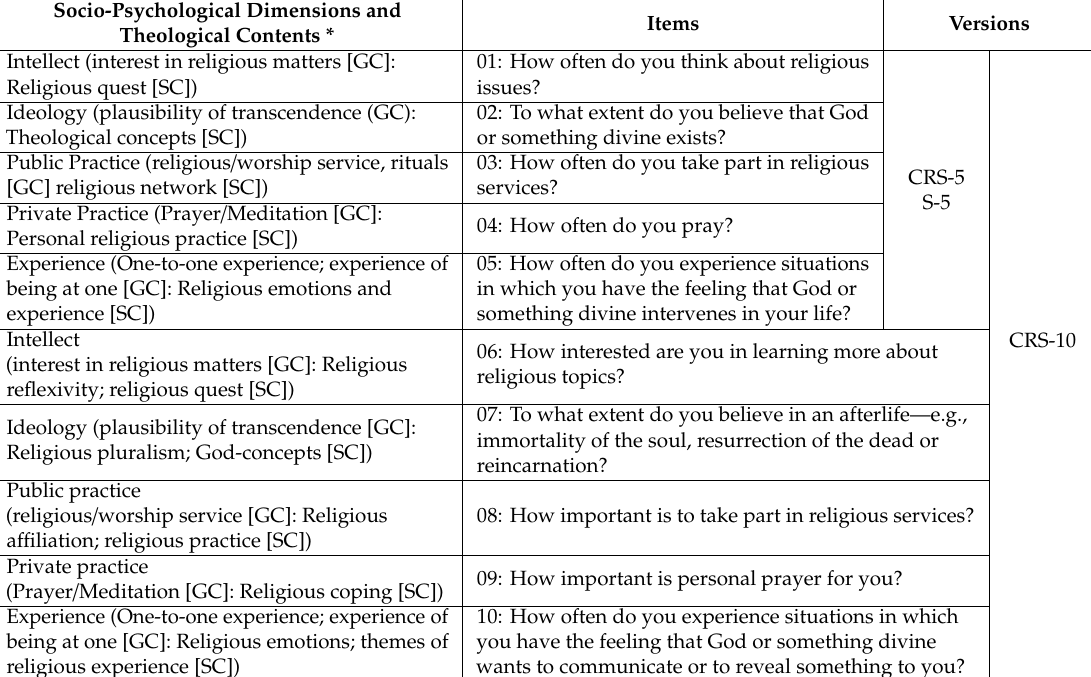
Table 1. Items and versions (5 and 10) of the centrality of religiosity scale (CRS). * General contents (GC) and specific contents (SC). Adapted from Huber